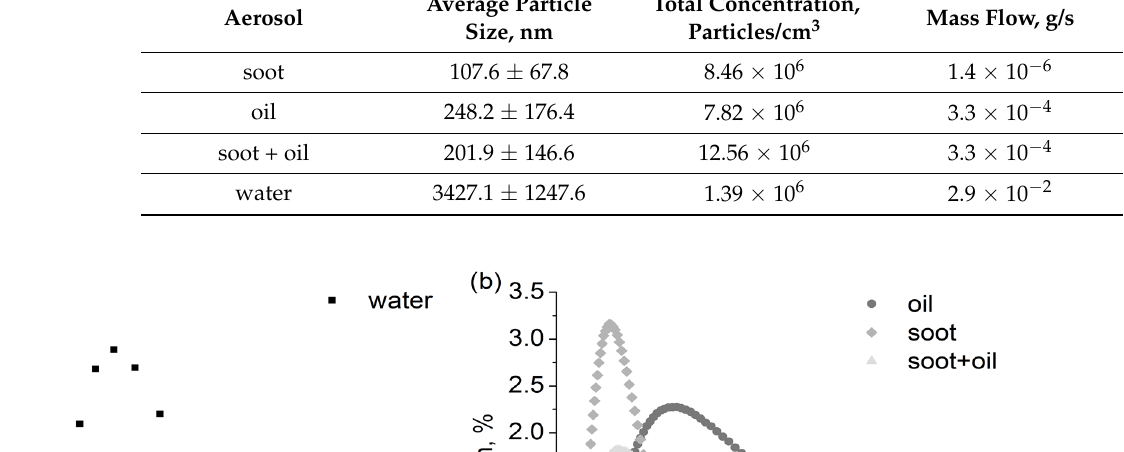
Table 1. Properties of aerosols utilised in experiments.